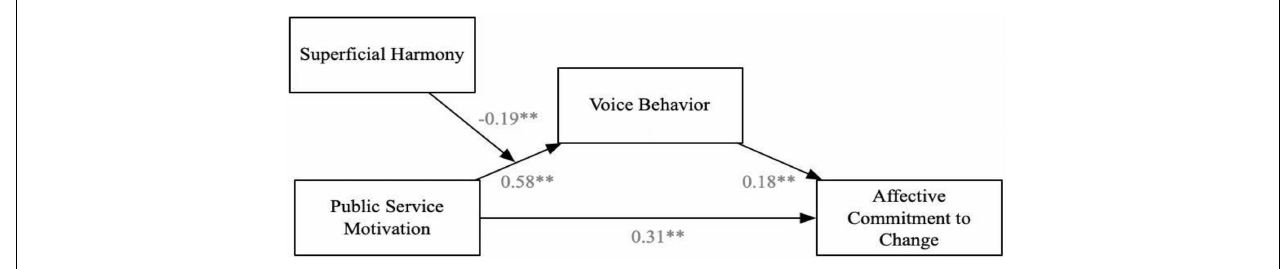
FIGURE 1 | Results of theorical model. **p < 0.01.